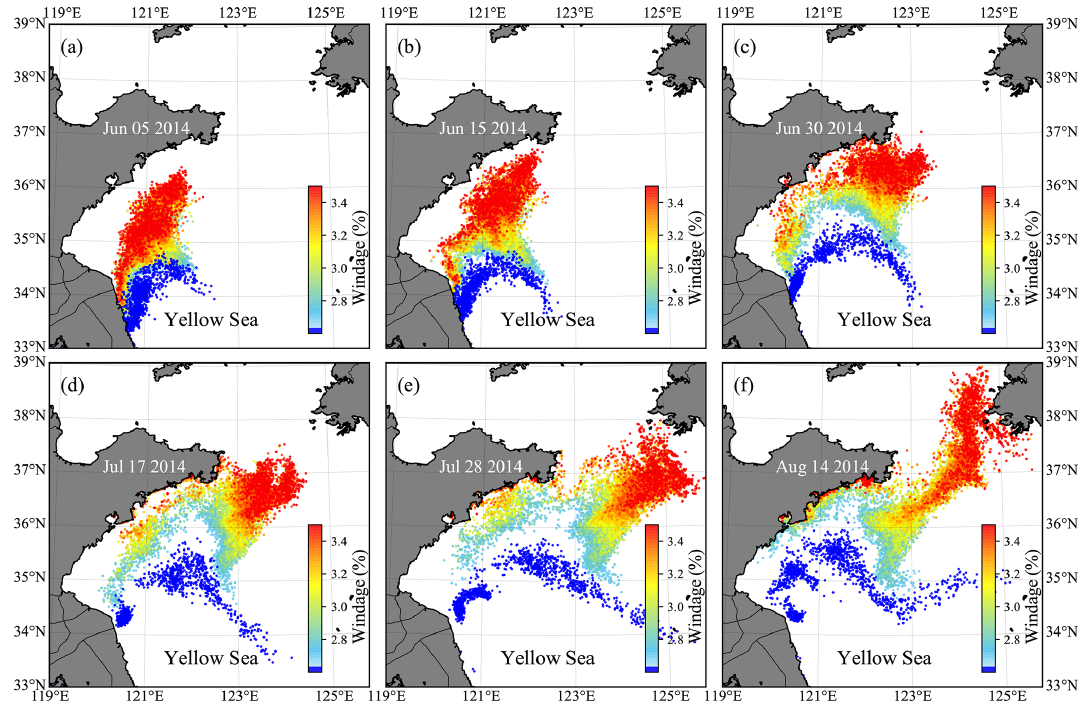
Figure 9. Evolution of the particle distribution in FMGDM tracking simulations. Colors indicate the different windage (2.7%–3.5%) of the simulated particles. The blue particles indicate the simulation without direct windage. (a) 5 June 2014; (b) 15 June 2014; (c) 30 June 2014; (d) 17 July 2014; (e) 28 July 2014; (f) 14 August